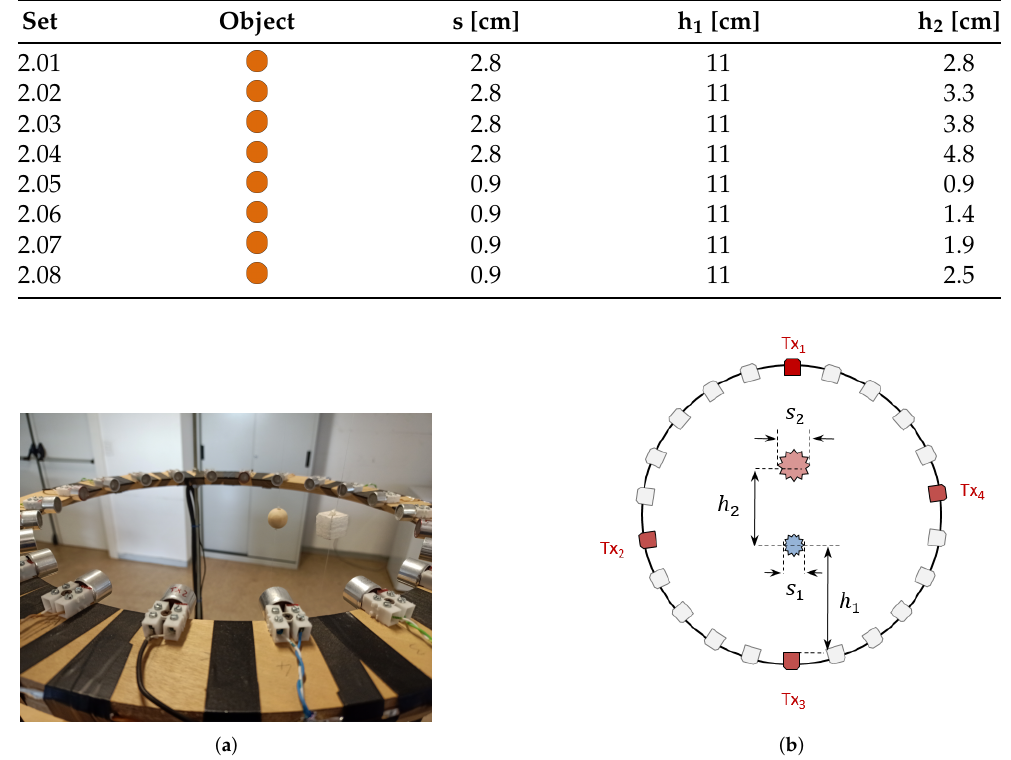
Table 3. Scenario 2: two wooden spheres of equal size (Figure 6).